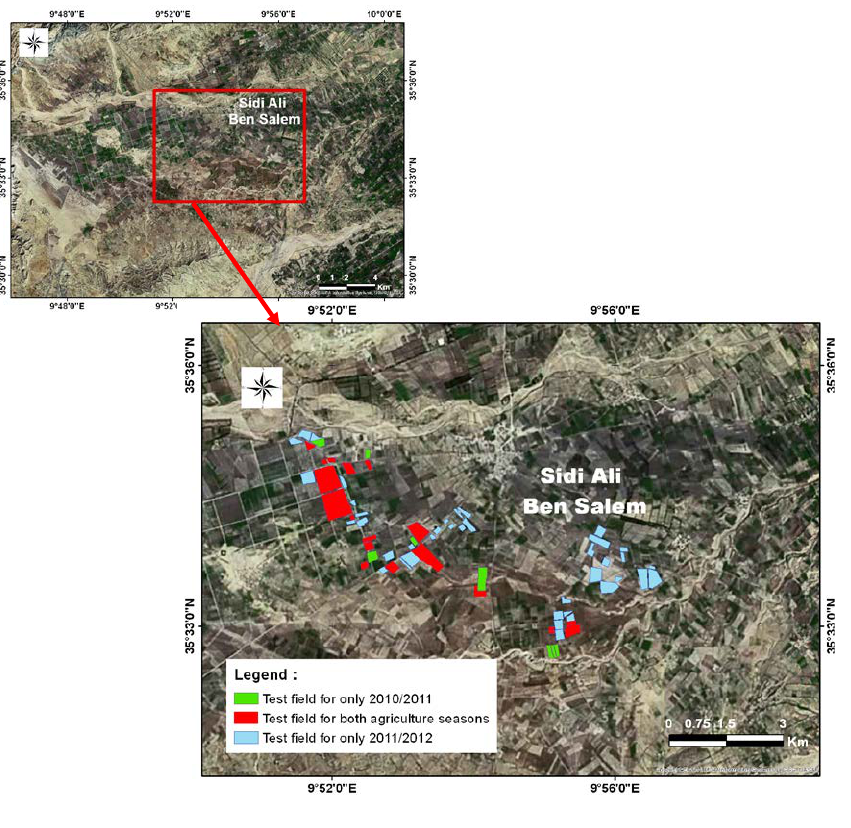
Figure 2. Color-coded view of the test fields.